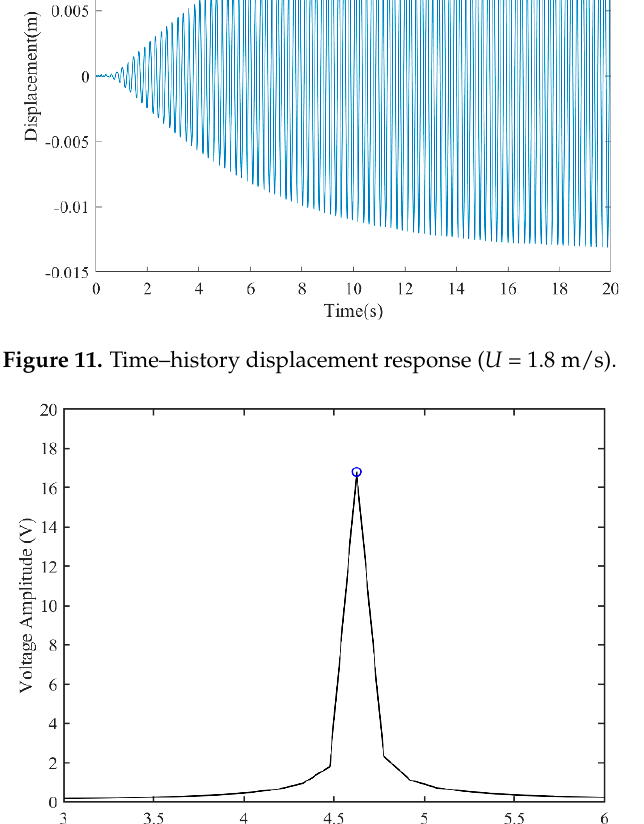
Figure 12. Fast Fourier transform (FFT) of the steady-state part of the voltage–time response. ( U = 1.8 m/s).